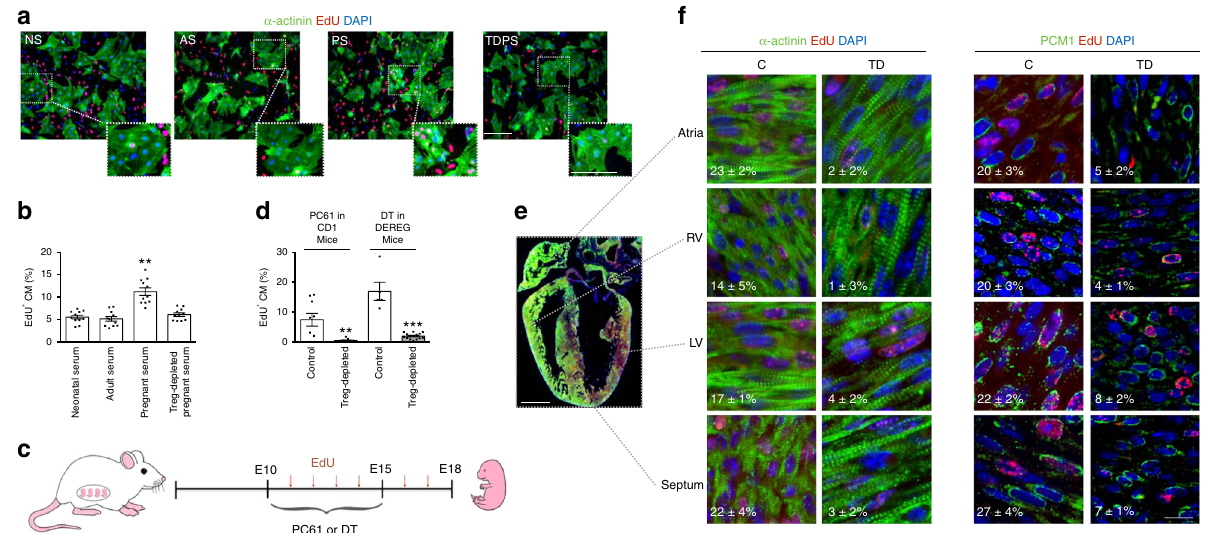
Fig. 1 Tregs in the maternal serum promote CM proliferation. a Rat neonatal CMs were exposed to the serum collected from neonatal (NS), adult (AS), pregnant (PS) and Treg-depleted pregnant (TDPS) animals and proliferation measured by EdU incorporation. Nuclei are stained blue with 4 ’ -6-diamidino- 2-phenylindole (DAPI) and CMs green by anti- α -actinin antibodies. Red nuclei indicate EdU incorporation. Scale bar, 100 μ m. Insets shows a higher magni fi cation of the area de fi ned by the white dotted line. b Quanti fi cation of EdU + CM nuclei (% of total CMs) after exposure to the different sera. c Outline of the experimental procedure followed for Treg depletion in vivo in pregnant animal. The Treg-depleting agent, either PC61 antibodies in CD1 mice or Dyphteria Toxin (DT) in DEREG mice, was administered i.p. to the pregnant mother at embryonic days 10 (E10) and 15 (E15). EdU was administered i.p. every day from E10 to E18, when embryos were removed for histological analysis. d Quanti fi cation of EdU + / α -actinin CM nuclei (% of total CMs) in the heart of embryos harvested from either control (white bars) or Treg-depleted (gray bars) mothers, in the two models of Treg depletion described in panel ( c ). e Longitudinal section of a whole E18 heart, in which nuclei are stained blue with DAPI, CMs green by anti- α -actinin antibodies and EdU incorporation is shown in red. Scale bar, 1 mm. f High magni fi cation images of the indicated regions of embryonic hearts from control (C) and Treg-depleted (TD) mothers, in which nuclei are stained blue with DAPI, CMs green by either anti- α -actinin or PCM1 antibodies and EdU incorporation is shown in red. RV: right ventricle, LV: left ventricle. White numbers indicate the percentage of EdU + CMs in each cardiac region. Scale bar, 20 μ m. Values in ( b ) and ( d ) are mean ± s.e.m., n ≥ 3 biological replicates. One-way analysis of variance and Bonferroni/Dunn ’ s post hoc tests were used to compare multiple groups ( b ). Pairwise comparison was performed with the Student ’ s t -test ( d ). ** P < 0.01, *** P < 0.001 relative to